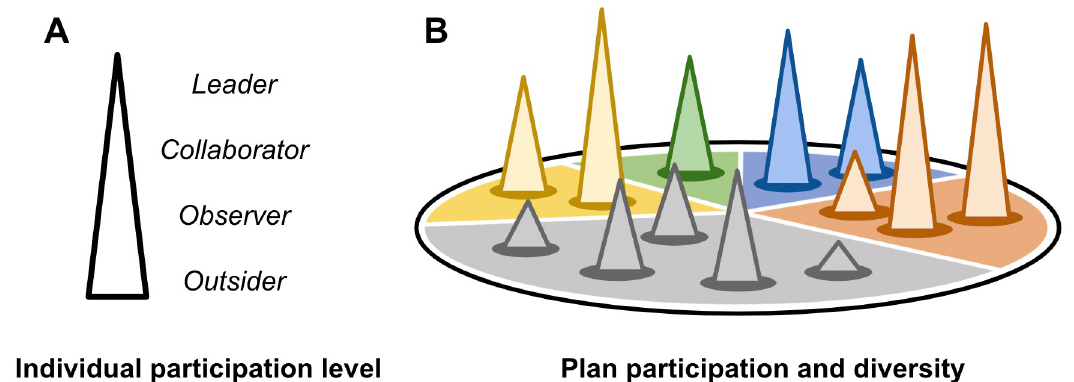
Fig 1. Collaborative planning as the combined result of the number and degree to which individuals participate in planning processes (Panel A), in addition to the groups, interests, and concerns that they represent (Panel B).